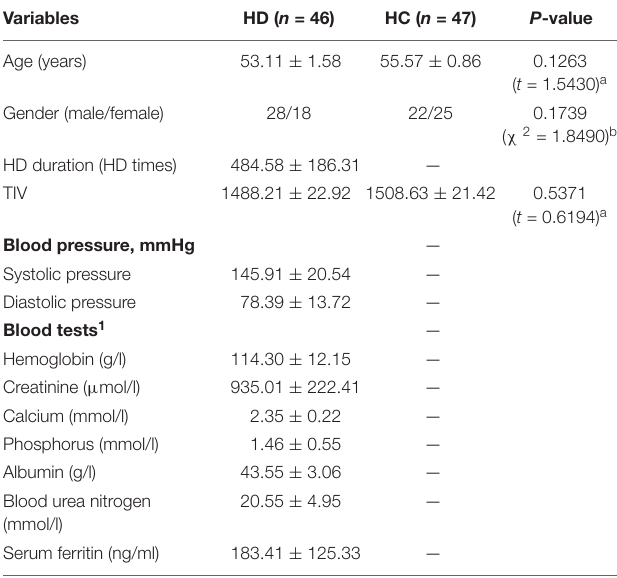
TABLE 1 | Demographic characteristics of study and control